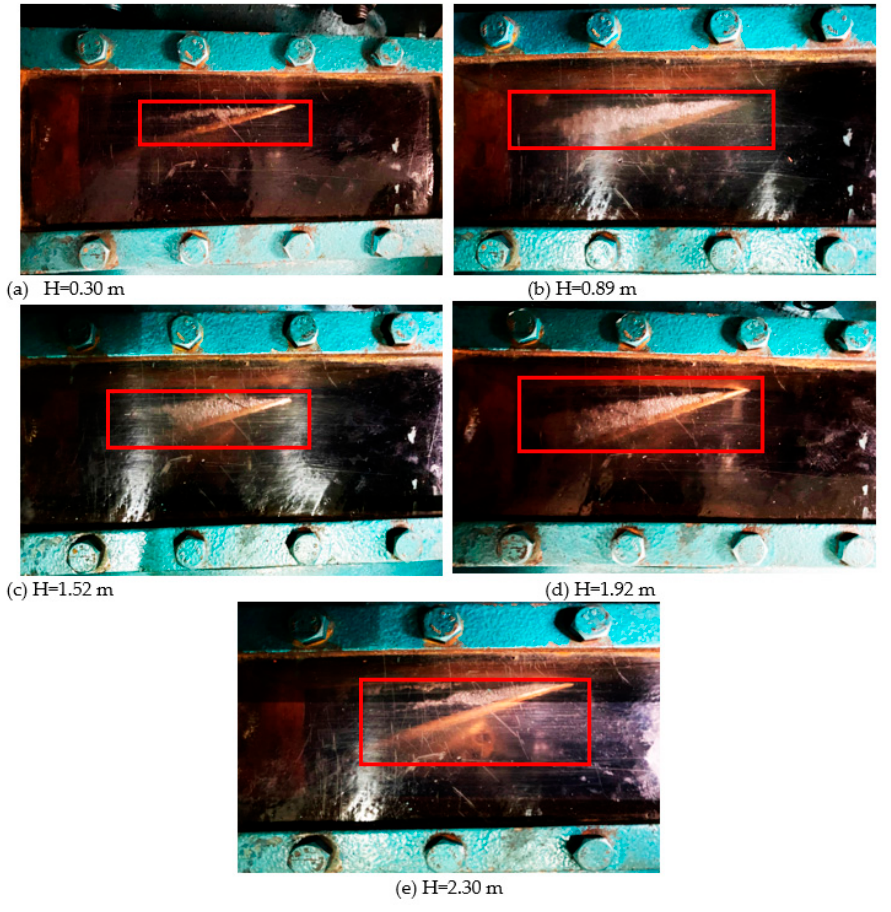
Figure 8. Cavitation diagram under five characteristic heads ( − 4°).